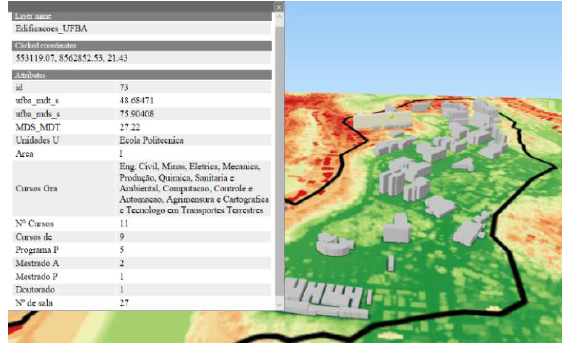
Figure 8: Query performed on the geometric model indicating the attributes of the